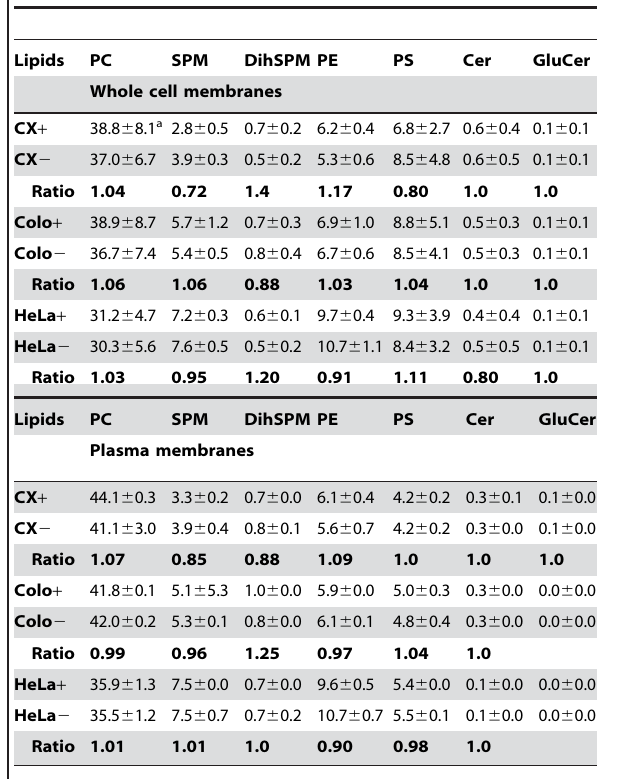
Table 2. Lipid composition and lipid ratio of whole cell membranes and purified plasma membranes of CX + /CX 2 , Colo + /Colo 2 , and HeLa + /HeLa 2 tumor sublines.